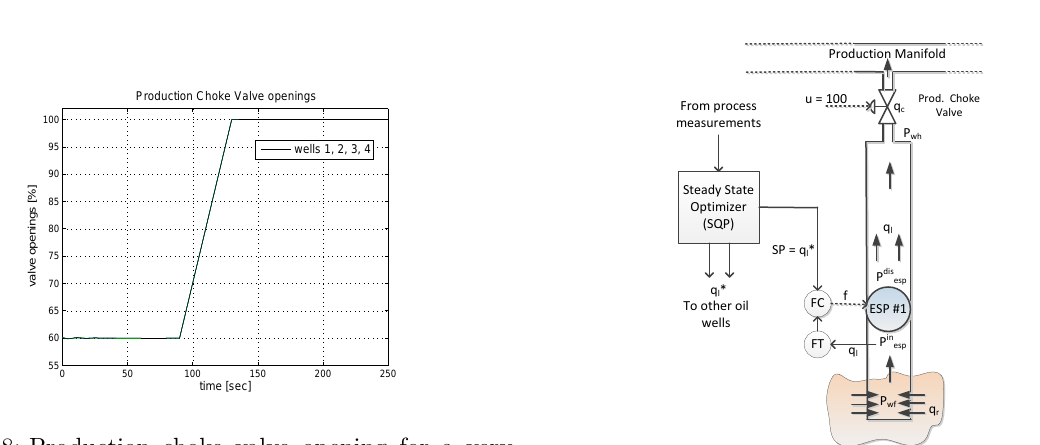
Figure 8: Production choke valve opening for a very high separator capacity